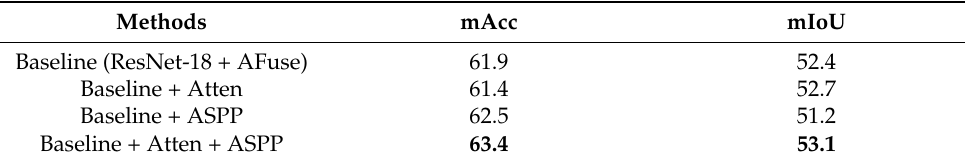
Table 5. The effectiveness of attention (Atten) and ASPP modules